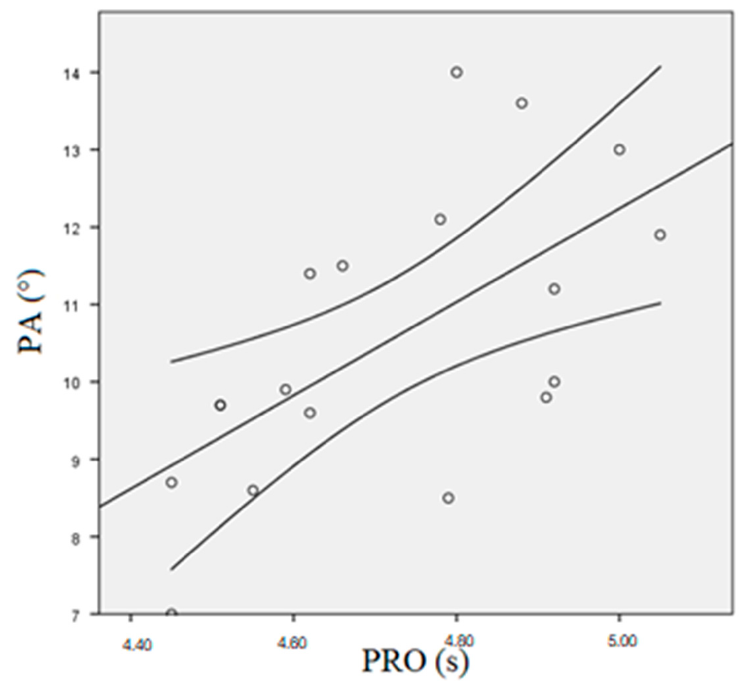
Figure 3. Scatter plot between PA of VL and PRO. PA = pennation angle. PRO = pro-agility test. The middle line represents the median and the parabolic lines represent the 95% confidence interval.